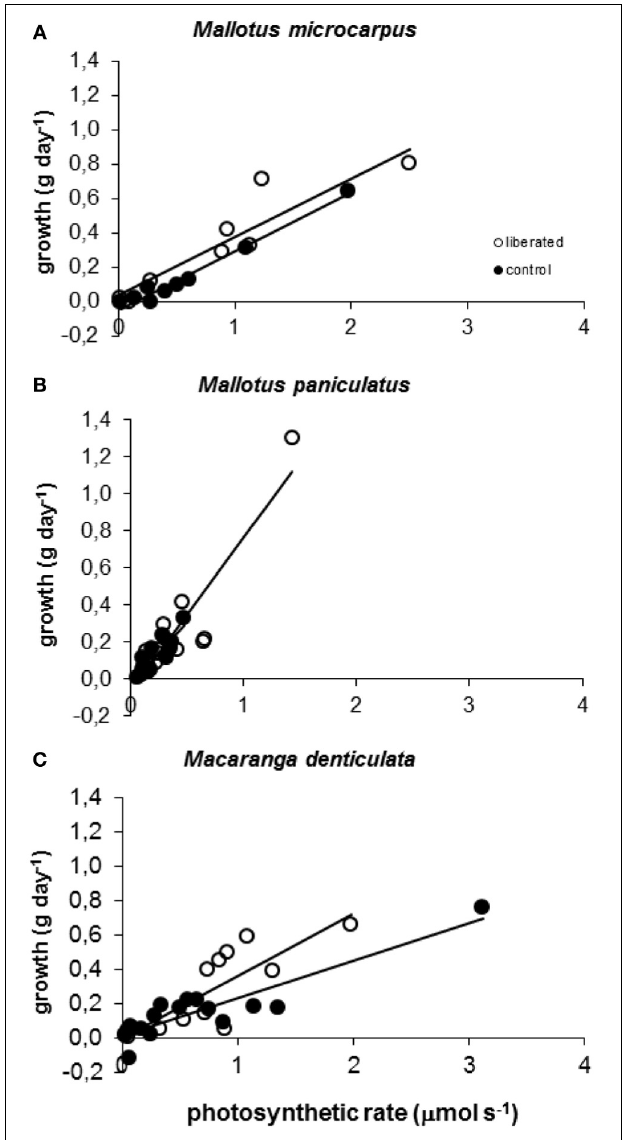
FIGURE 5 | (A–C) Correlation between observed above ground biomass growth in 174 days after vegetation removal and calculated values of whole canopy photosynthetic rates immediately after vegetation removal obtained with the PHOLIAGE model. All correlations are significant (MM, p < 0 . 01) and r 2 values varied from 0.6928 to